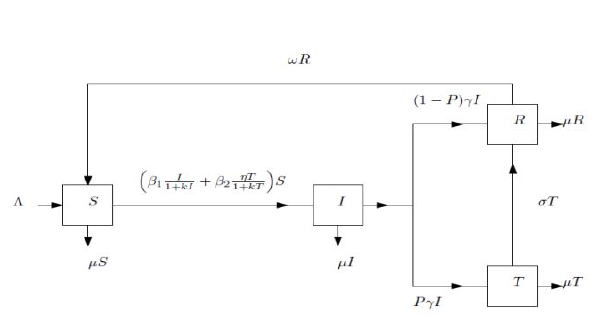
Figure 1. Schematic of diarrhoea model with saturated